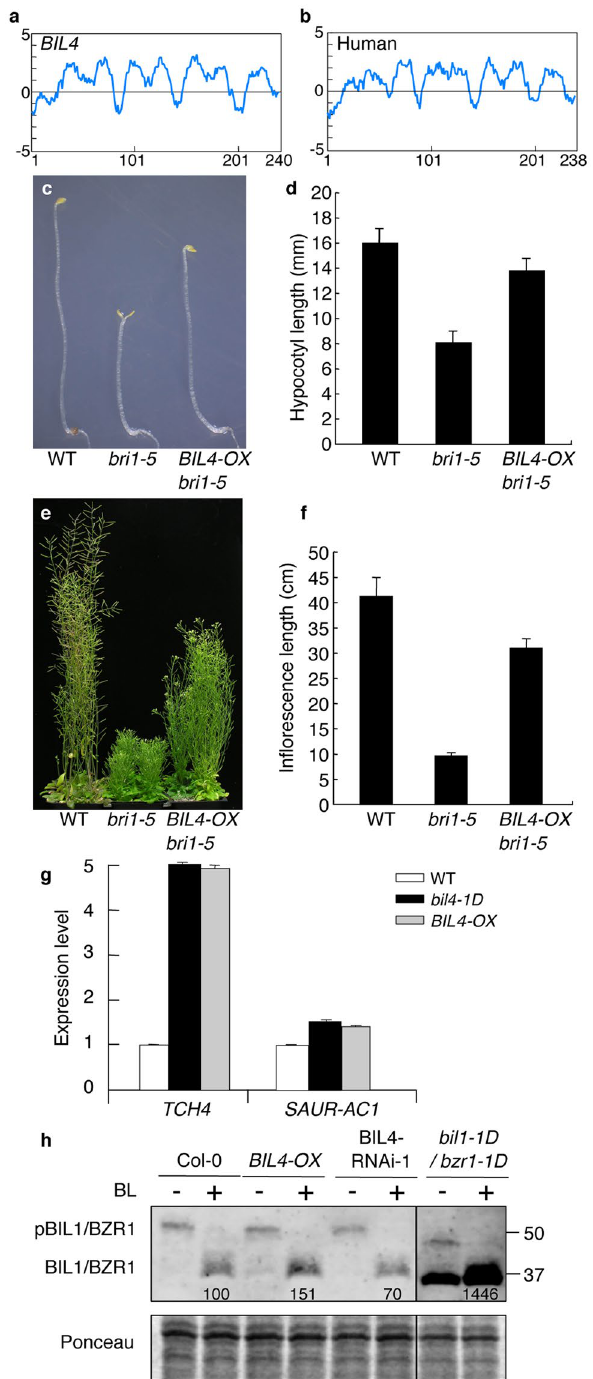
Figure 1. BIL4 is a positive regulator of BR signaling. ( a , b ) Hydrophobicity profiles of BIL4 ( a ) and the human homolog Golgi anti-apoptotic protein (hGAAP) ( b ). ( c,d ) Phenotype ( c ) and hypocotyl length ( d ) of wild- type (WT), bri1-5 and BIL4-OX bri1-5 double mutant seedlings grown in the dark for 7 days. The results are presented as the mean ± s.d. (n > 30 seedlings). ( e , f ) Phenotype ( e ) and inflorescence length ( f ) of WT, bri1-5 and BIL4-OX bri1-5 plants grown in soil for 6 weeks. The results are presented as the mean ± s.d. (n > 20 plants). ( g ) qRT-PCR analyses of TCH4 and SAUR-AC1 expression levels in wild-type, bil4-1D , and BIL4-OX plants grown in the dark for 8 days. The results are presented as the mean ± s.d. ( h ) BIL1/BZR1 phosphorylation status in wild-type, BIL4-OX , BIL4-RNAi-1 and bil1-1D/bzr1-1D plants (pBIL1/BZR1, phospho-BIL1/BZR1). Plants that were grown on medium containing 3 µ M Brz in the dark for 7 days were submerged for 3 hr in medium containing 100 nM BL. Western blot analyses were performed using the anti-BIL1/BZR1 antibody (upper panel). The protein levels were detected using Ponceau S (lower panel). Numbers indicate the relative BIL1/ BZR1 signal levels normalized to the Ponceau S-stained protein